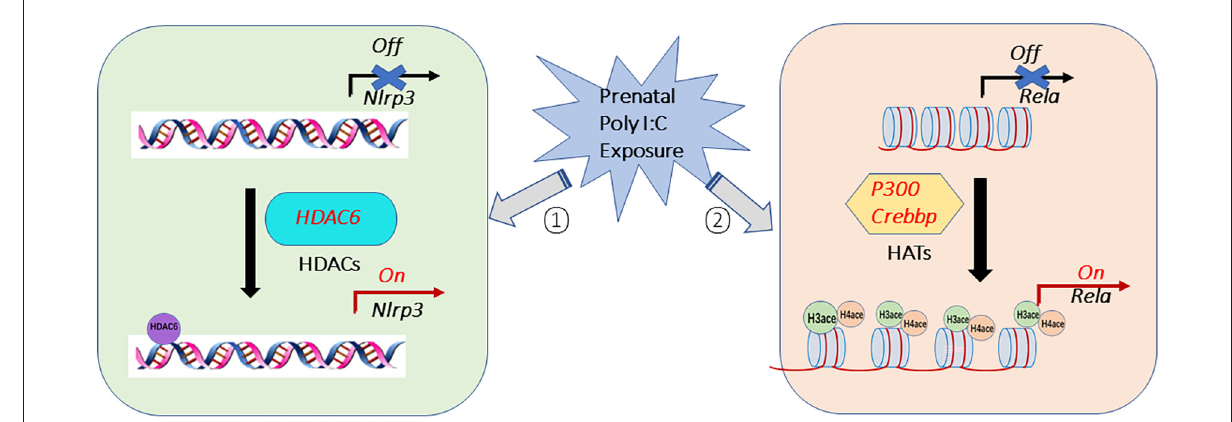
FIGURE7 Potential epigenetic histone acetylation mechanisms for elevated neuroinflammation caused by prenatal Poly I:C exposure in the prefrontal cortex of female juvenile offspring rats. The activation of the NF- κ B/NLRP3 inflammatory pathway induced by prenatal Poly I:C exposure may via (cid:192) activating histone acetyltransferases (HATs) of EP300 (p300 ) and CBP ( Crebbp ), which thus enhances histone H3 and H4 acetylation on the promoter region of Rela , a subunit of NF- κ B, (cid:193) activating histone deacetylases of HDAC6 ( Hdac6 ), which increases HDAC6-mediated NLRP3 transcriptional